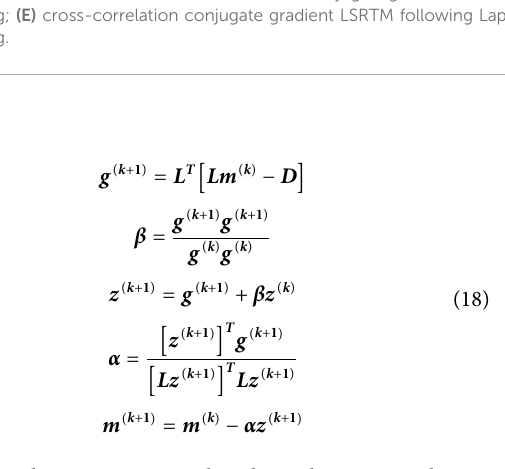
FIGURE 2 RTM and LSRTM migration pro fi les of a simple model. (A) cross-correlation RTM migration result; (B) result of cross-correlation conjugate gradientLSRTMwith20iterations; (C) resultofconjugategradientnormalizedLSRTMwith20iterations; (D)